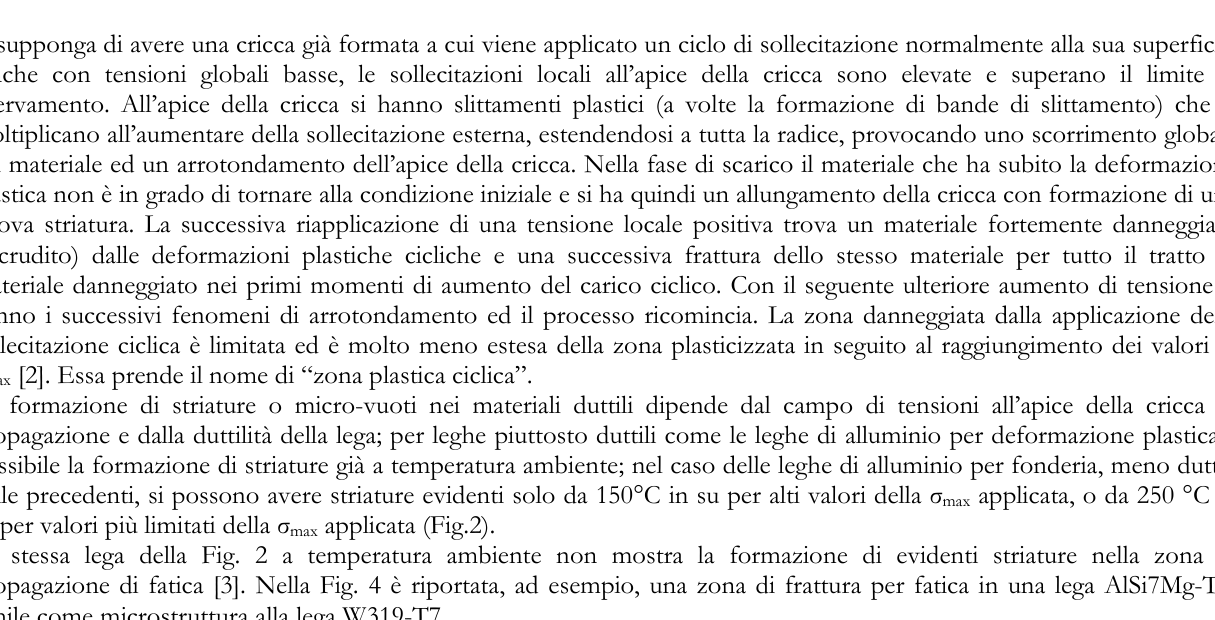
Figura 3: Modello di propagazione delle cricche per arrotondamento plastico [1]. Figure 3: Plastic blunting crack propagation model [1].